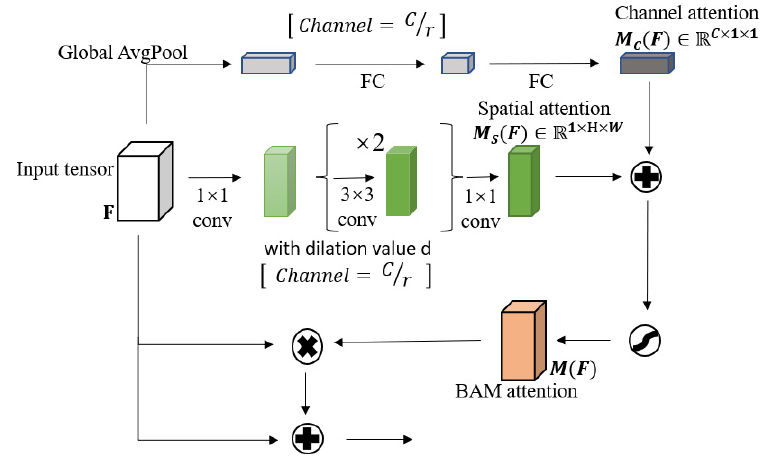
Figure 3. Schematic diagram of clustering.